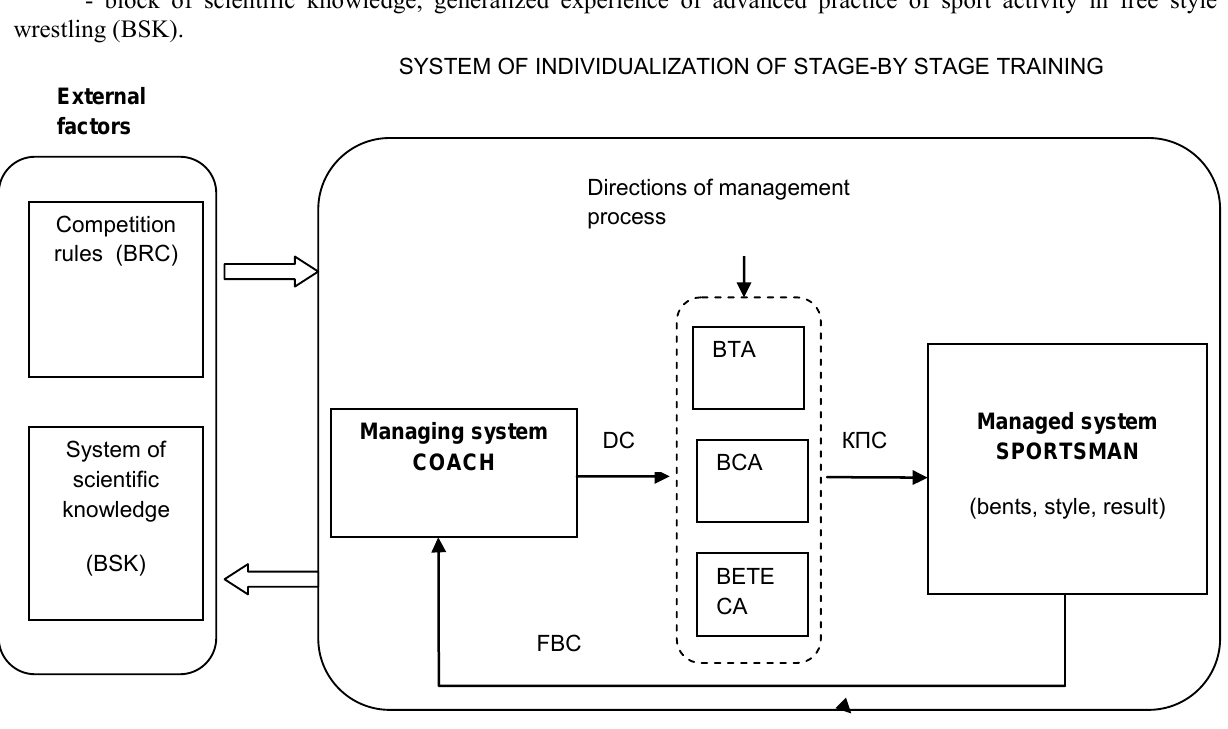
Fig.1. Structural-logical diagram of system of individualization of stage-by-stage training in free style wrestling ISSBST itself consists of managing sub-system (subject of management)- coach and managed sub-system (object of management) –